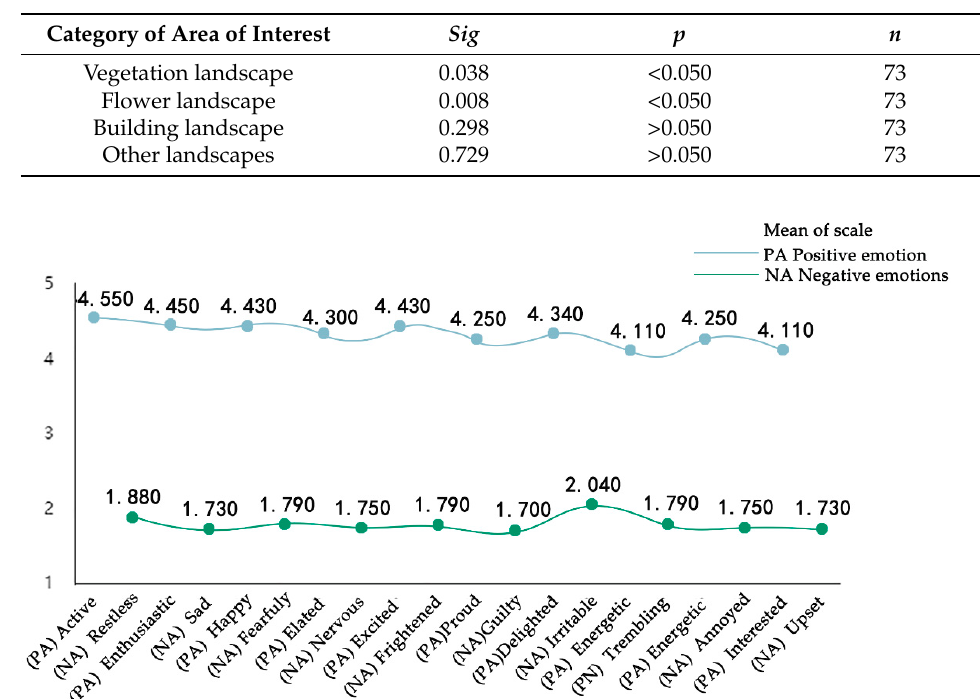
Table 1. Statistical results of the correlation between level of interests and stress emotion.